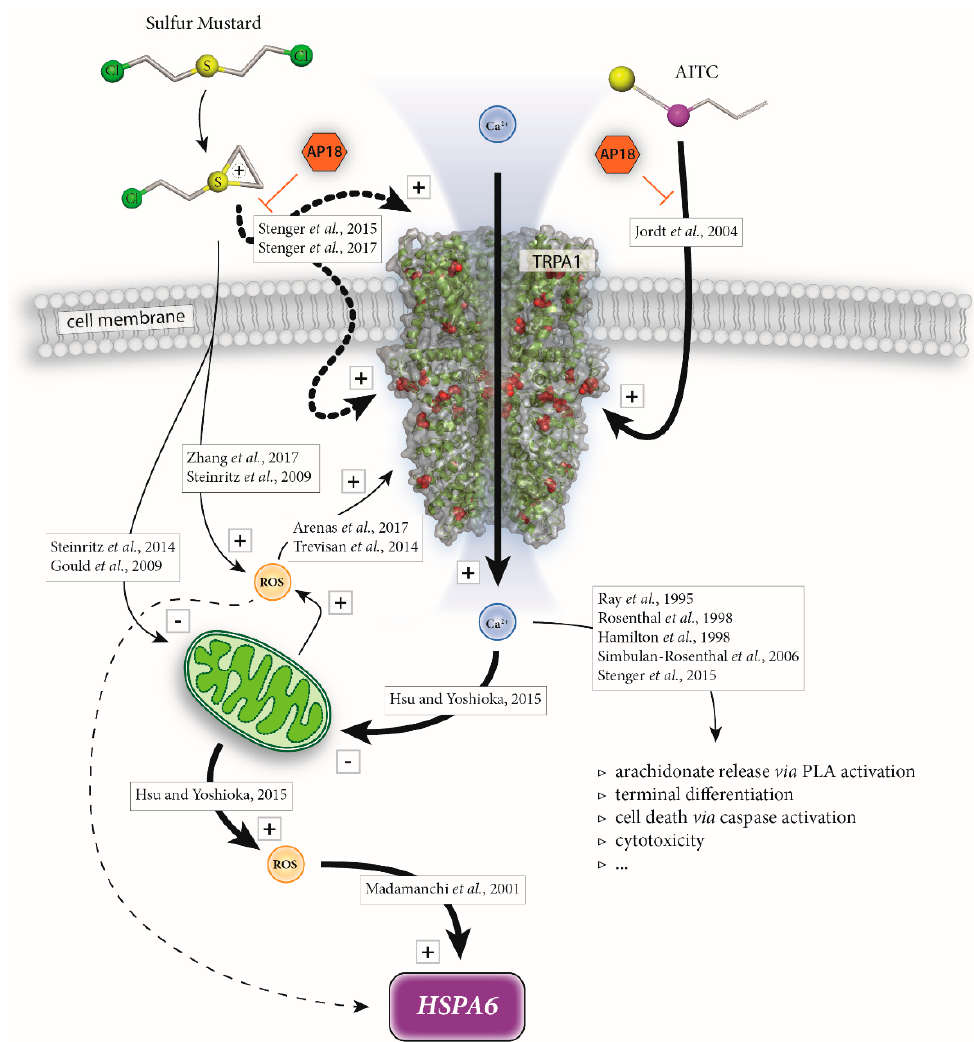
Figure 4. Schematic overview suggesting TRPA1-mediated induction of HSPA6 after SM exposure. SM activates TRPA1 channels with a still unknown extra- or intracellular binding site (bold dotted lines). SM as well as AITC treatment increase intracellular Ca 2+ ([Ca 2+ ] i ) levels. AP18 prevents both SM- and AITC-induced TRPA1 activation. [Ca 2+ ] i affects mitochondrial function thereby producing ROS which triggers HSPA6 induction. SM may also cause ROS formation through disturbance of mitochondrial function or other yet not well-defined mechanisms thereby potentially contributing to HSPA6 induction (dashed line) without involvement of TRPA1. Elevation of [Ca 2+ ] i also results in additional biological effects (open triangles). Text boxes list references describing the illustrated effects. Activation, increase or induction is marked with “+” while impairment of mitochondria is indicated with “ − ”.